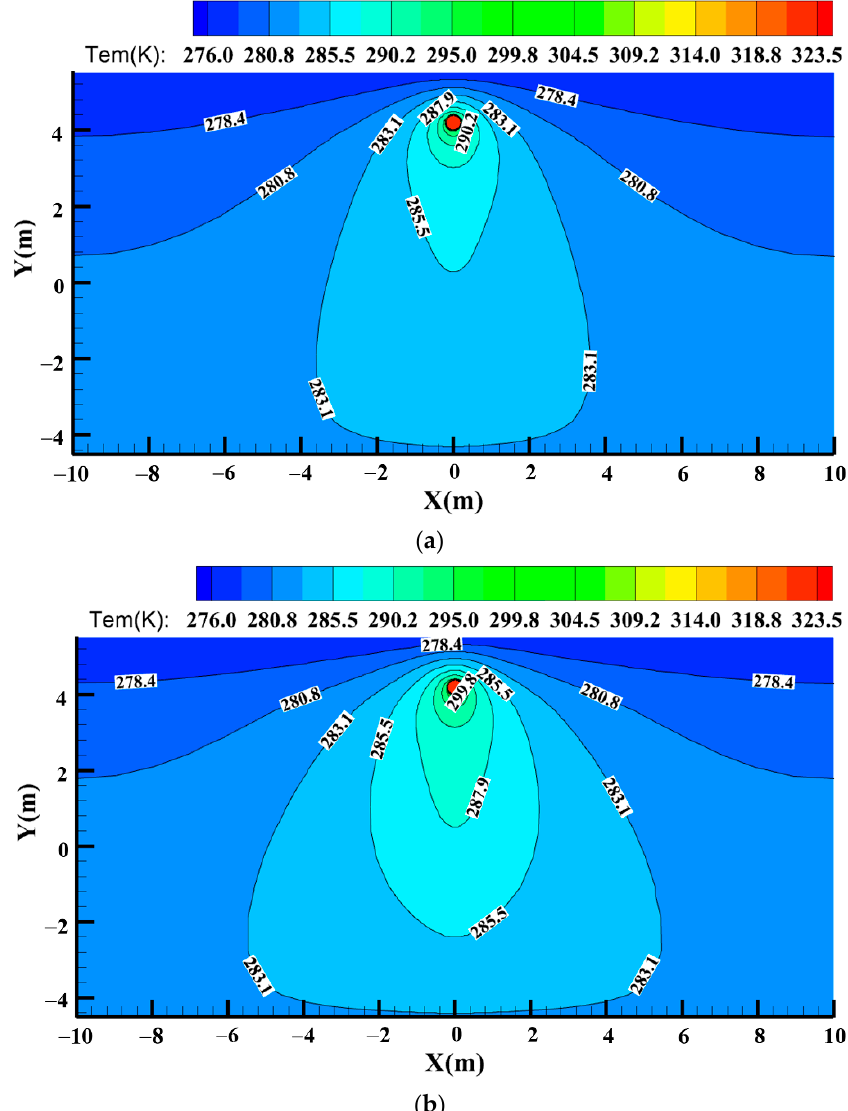
Figure 12. Temperature field on the cross section with oil flow rate at ( a ) 0.9 m/s and ( b ) 1.2 m/s. As can be seen from the contours, the range of the core thermal response zone increases significantly with the increase in velocity. Specifically, when the velocity increases from 0.9 m/s to 1.2 m/s, the maximum value of the 283.1 K isotherm in the X direction expands from 3.5 m to 5.2 m. Therefore, it is only appropriate to reduce the computational domain in the condition of a small velocity of oil